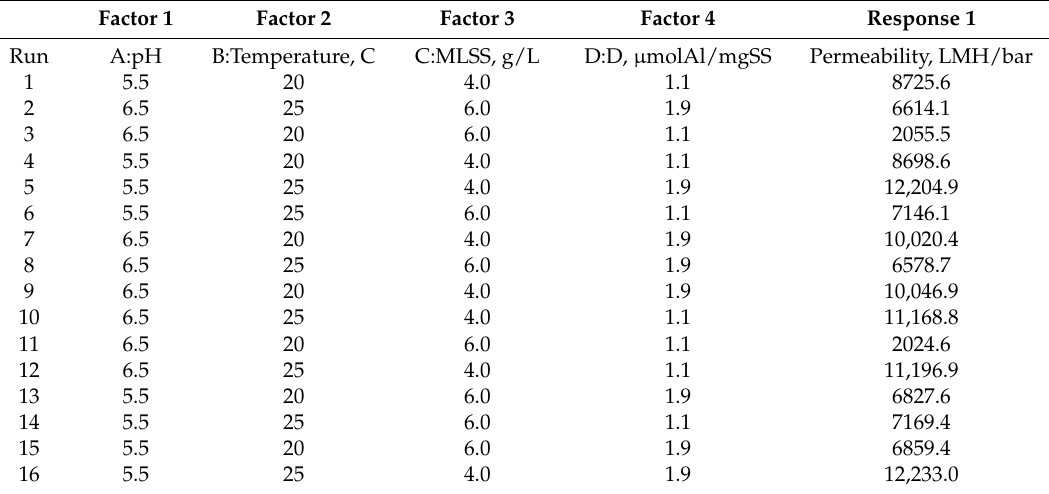
Table 5. Layout for a designed